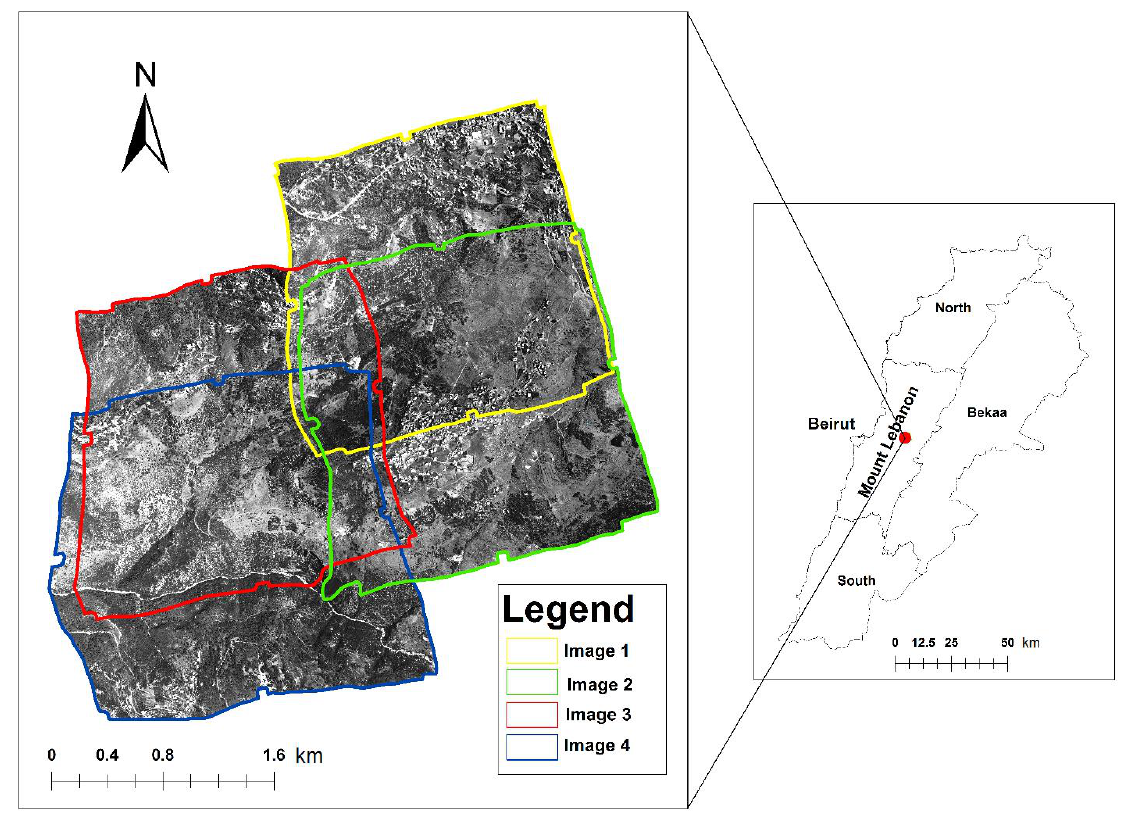
Figure 1. Study area.